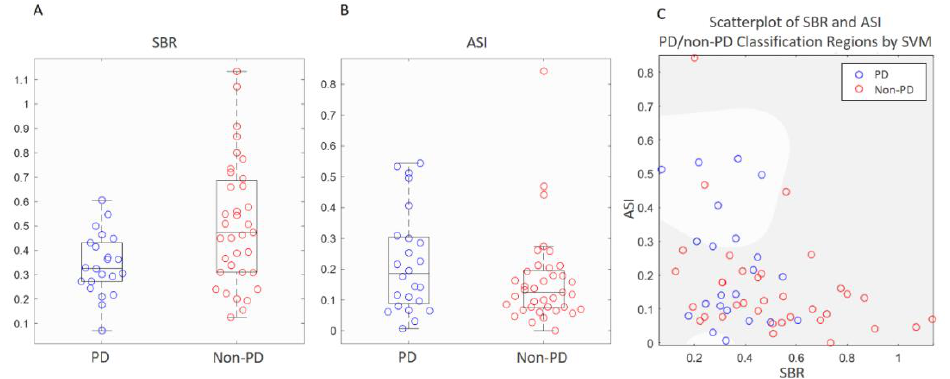
Figure 3. Distribution of indicators derived from semi-quantitative methods (SBR and ASI) in the test dataset (n = 57). ( A ) Dot diagram overlaid whisker-boxplot of SBR showed a wider range of distribution in the non-PD group. The range of the PD group almost totally overlapped with that of the non-PD group. ( B ) Dot diagram overlaid whisker-boxplot of ASI showed a wider range of distribution in the PD group. The range of the non-PD group almost totally overlapped with that of the PD group. ( C ) Scatterplot of SBR and ASI of both groups showing the classification results of median Gaussian kernel SVM with PCA. In the PD (lighter) region only one non-PD point was included, while there were 12 PD points in the non-PD’s (darker) region. The overall accuracy was 68.4% using this machine-learning method. Table 2. Comparisons of the prediction accuracy of the test dataset with different classifiers.